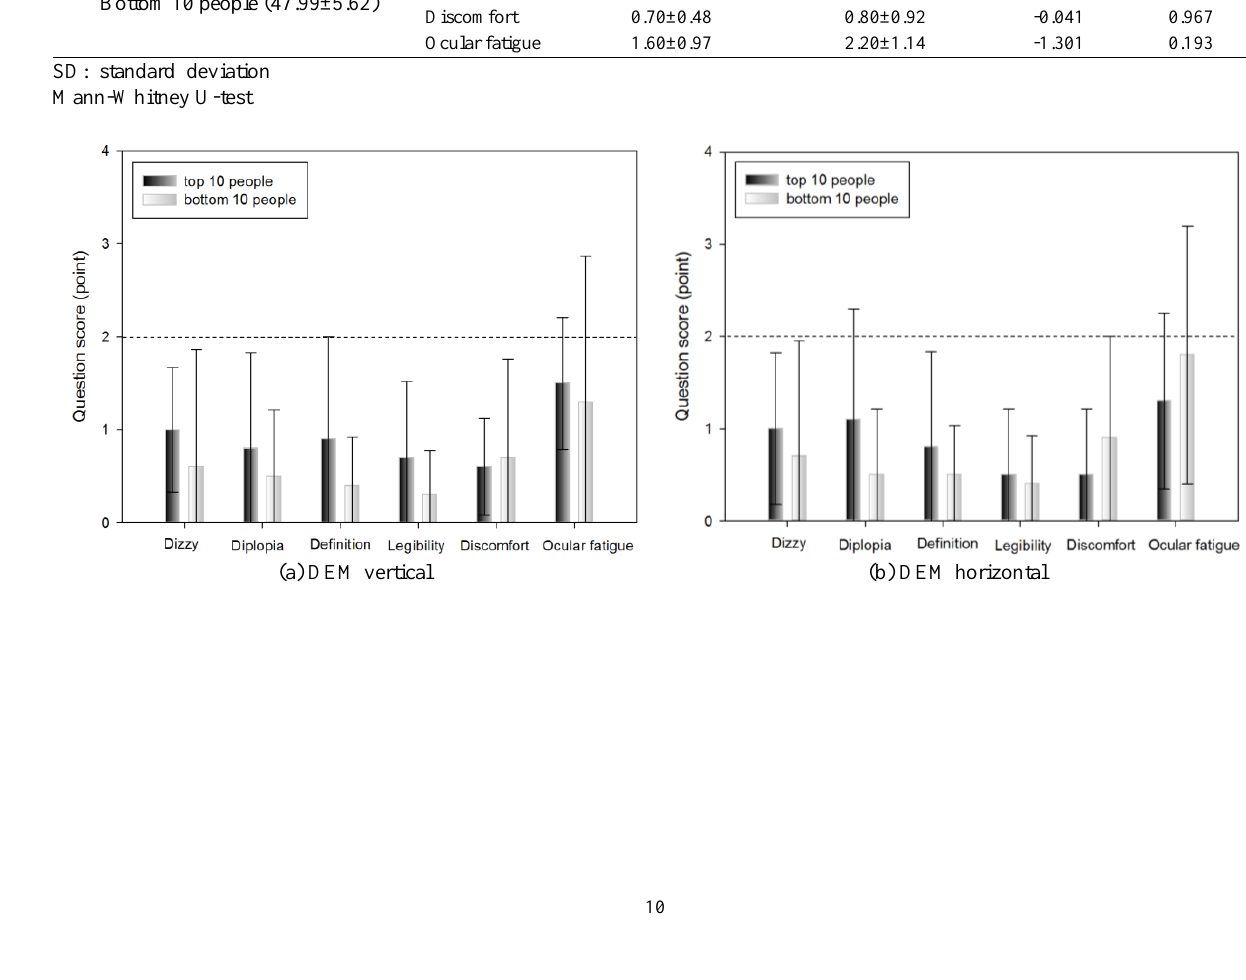
VHD verticality Top 10 people (23.67±1.19) Bottom 10 people (36.11±4.58)